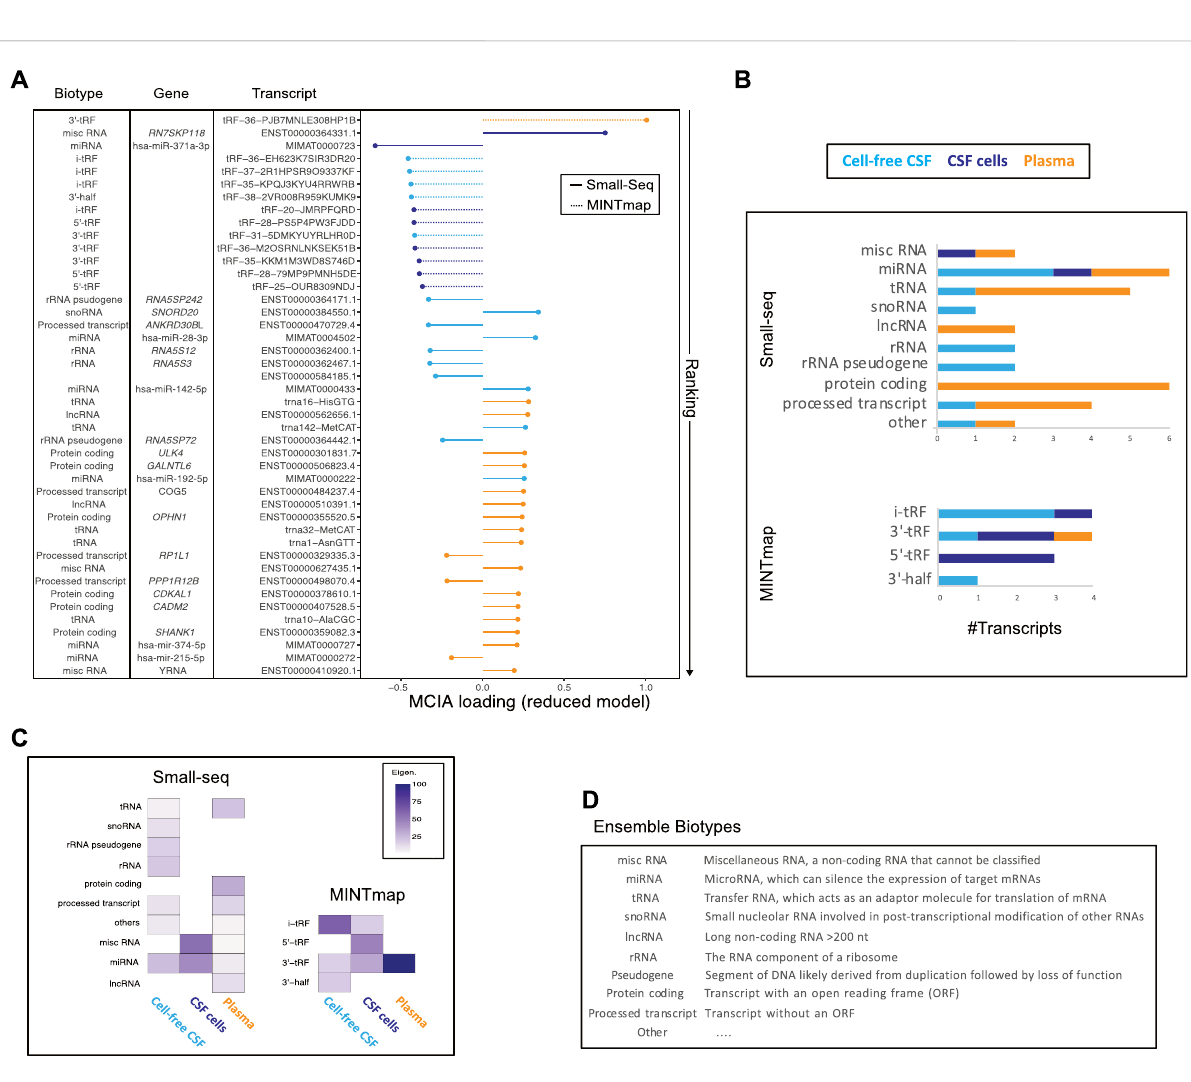
FIGURE 4 Transcript biotype and source contribution to the reduced model. (A) Plotting of ranked multiple co-inertia analysis (MCIA) loadings color- codedaccordingtothesource(cell-freeCSF:lightblue,CSFcells:darkblueandplasma:orange),andlinetypeaccordingtoanalysispipelinewithfull line representing Small-seq and dashed representing MINTmap, respectively. Transcript biotype, gene name and transcript IDs are given. (B) Overview of #transcripts from different biotypes derived from plasma (orange), CSF cells (dark blue) and CSF (light blue), which are included in the reduced model. Transcripts were divided into Small-seq and MINTmap pipelines, respectively. (C) Heatmap illustrating the contribution of different biotypes and sources, with dark purple illustrating most, and lighter color illustrating less contribution. (D) Explanation of various biotypes modi fi ed from